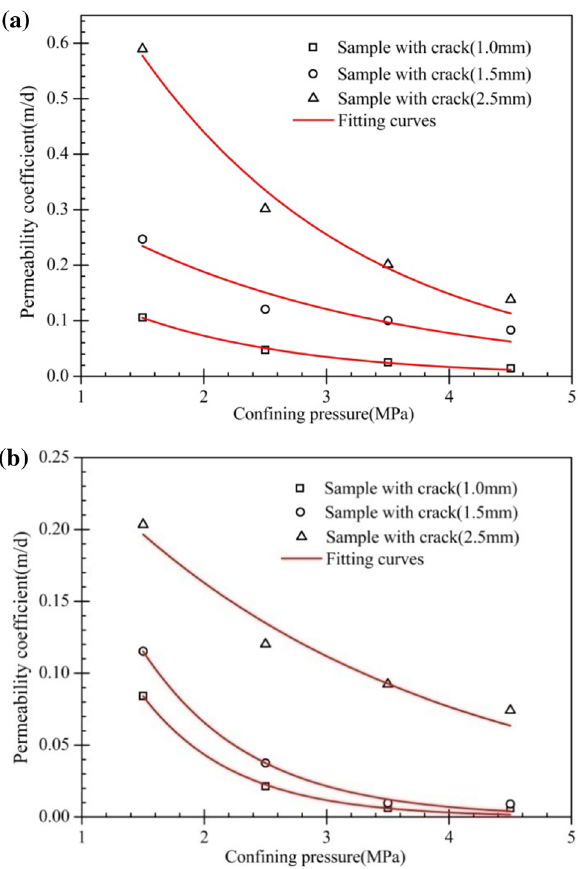
Fig. 11 Relationship curves of permeability coefficient and confining pressure: a Jingle laterite, b Baode Table 5 Fitting parameters of the relationship between the perme- ability and confining pressure Laterite specimens(crack width)